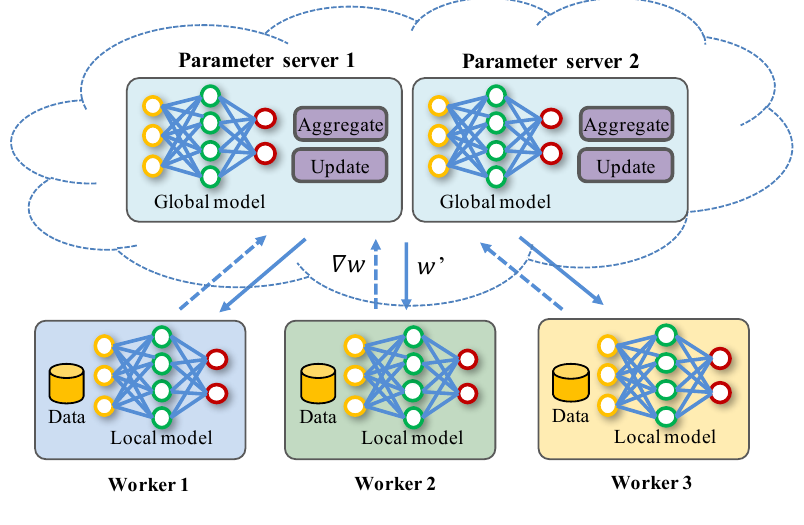
Figure 3. Parameter